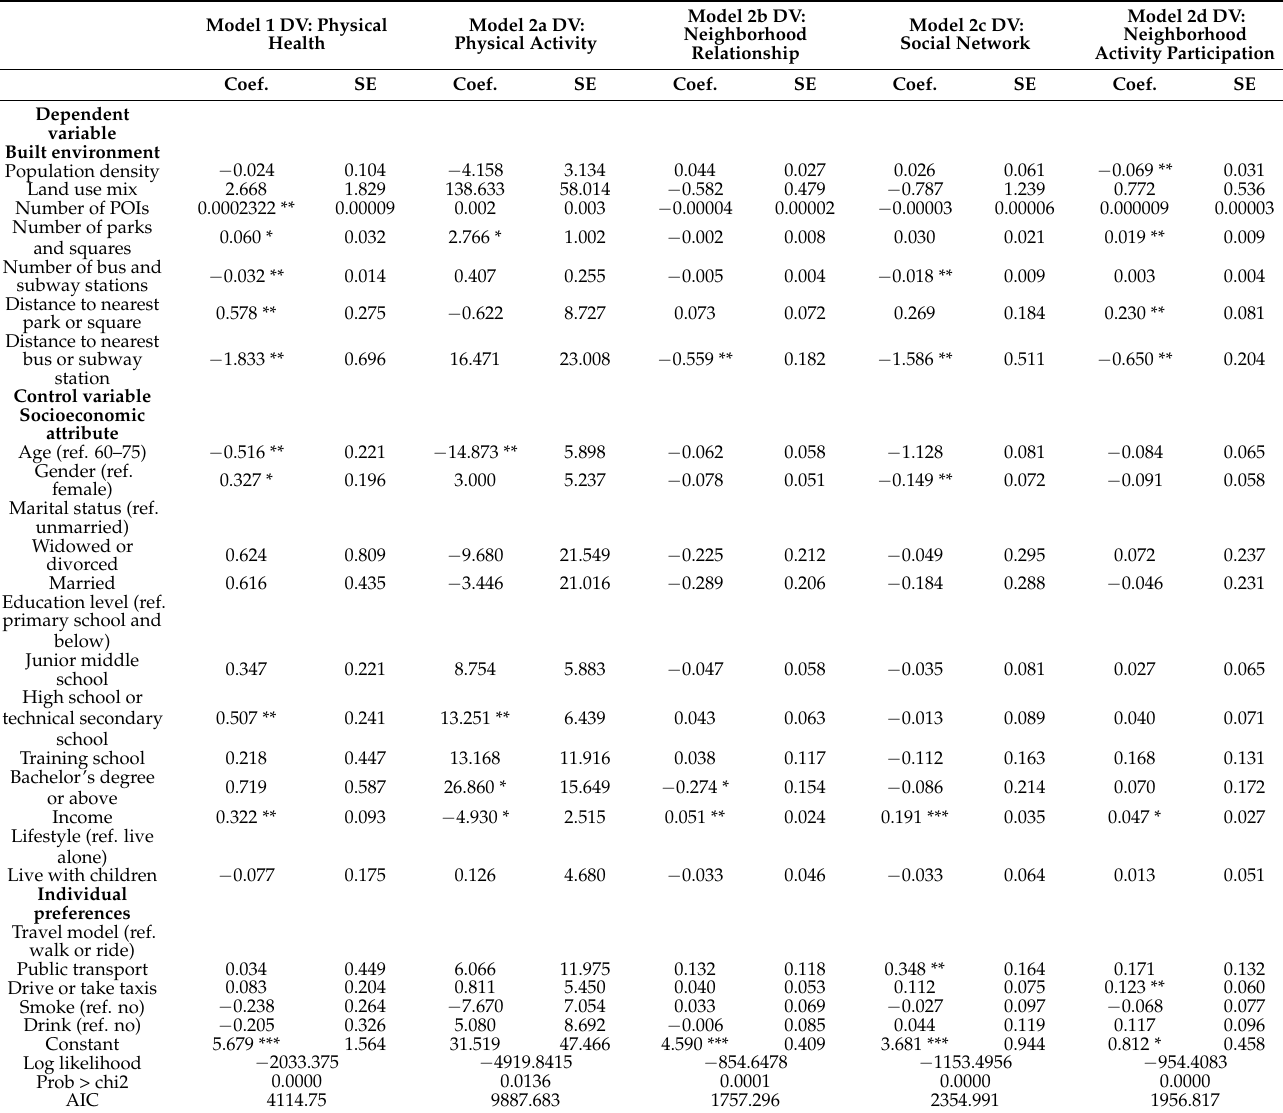
Table 3. Associations between the built environment and physical health of the elderly (possible